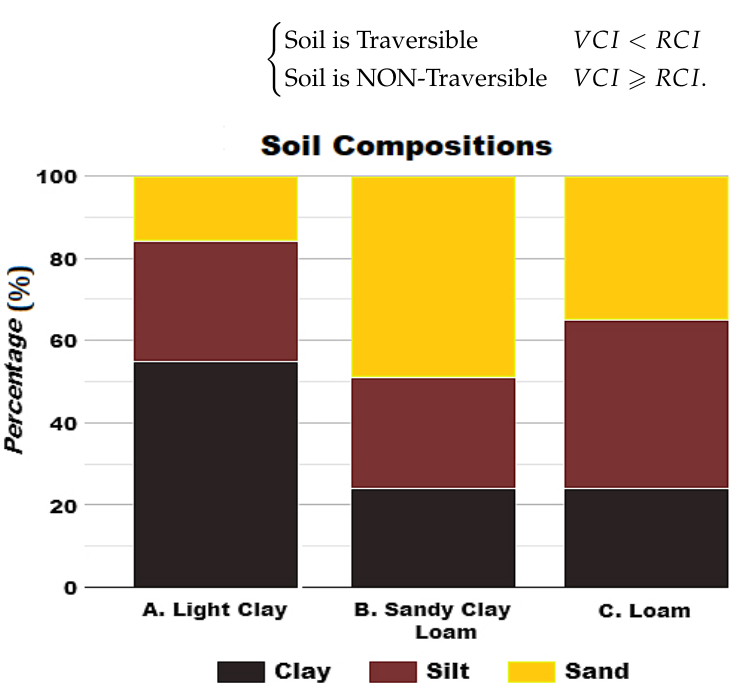
Figure 1. The three types of soil found in the real-life terrain employed for UGV routing in this